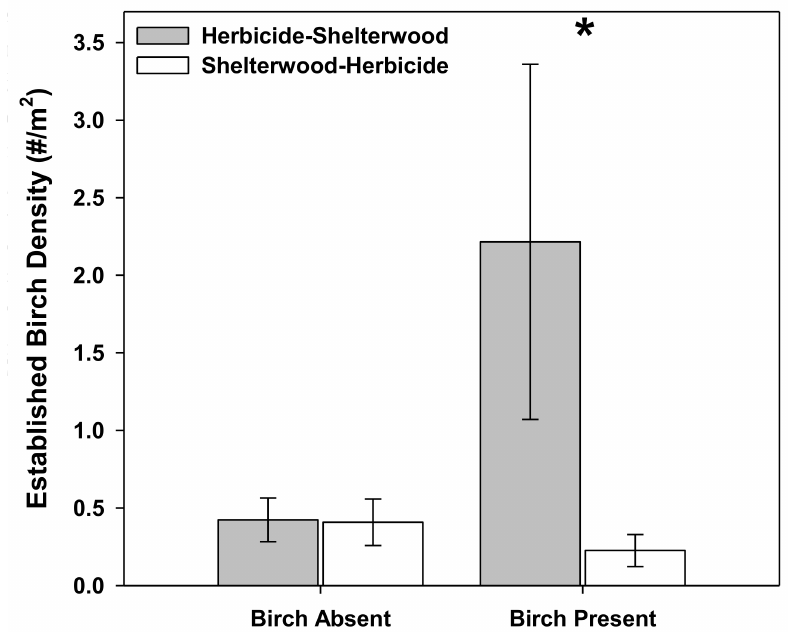
Figure 2. Effect of pre- versus post-shelterwood harvest herbicide application and presence of residual birch trees in stand (none/some) on birch seedling densities (# individuals >5 cm/m 2 ) over time. Asterisks denotes a significant Bonferroni-corrected difference between treatments at either level of the birch presence covariate.